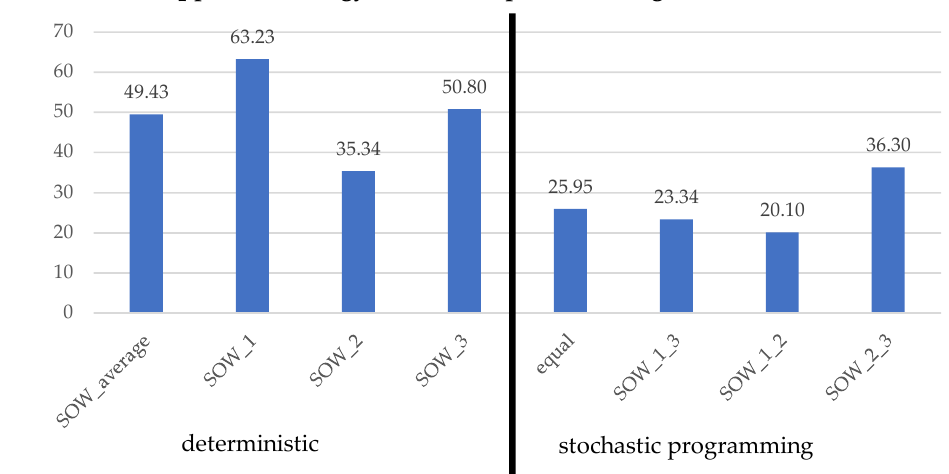
Figure 24. STCD per scenario for uncertain CO 2 prices and energy carrier cost (perfect foresight, without CCS).